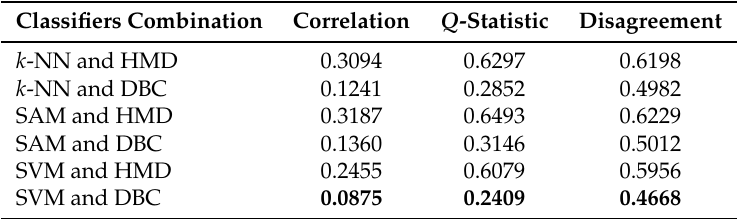
Table 2. Diversities of each pair of